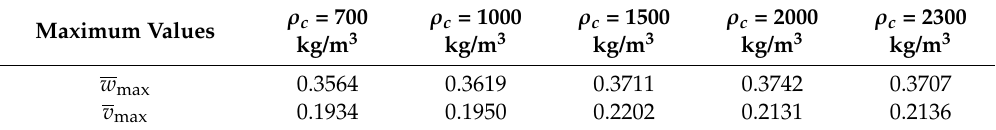
Table 7. Maximum deflections, velocities and stress of the plate center point versus time for different ρ c .